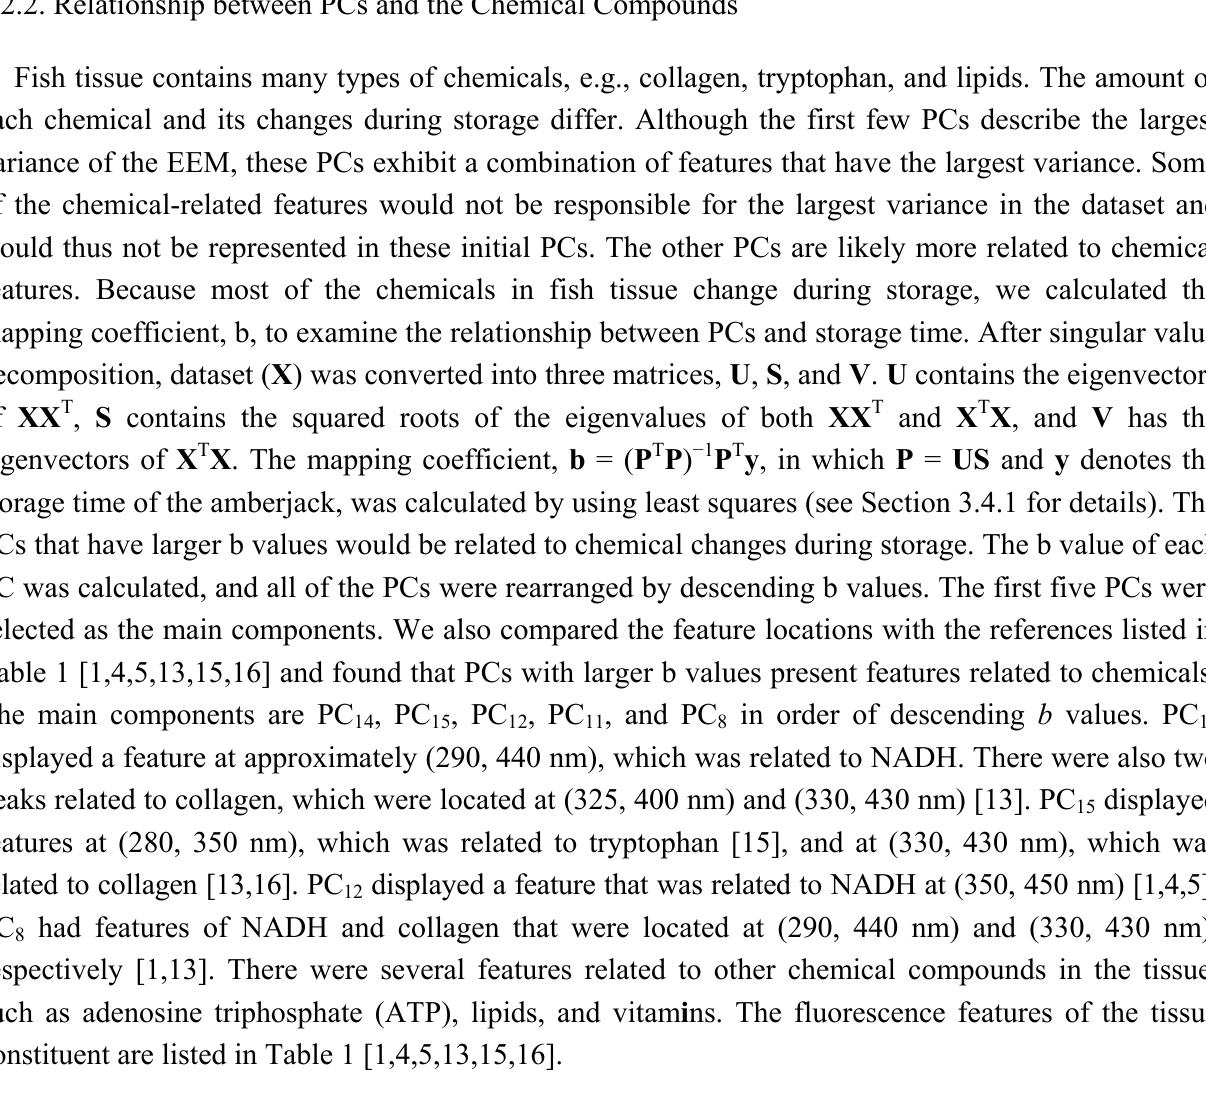
Table 1. Fluorescence features of the endogenous